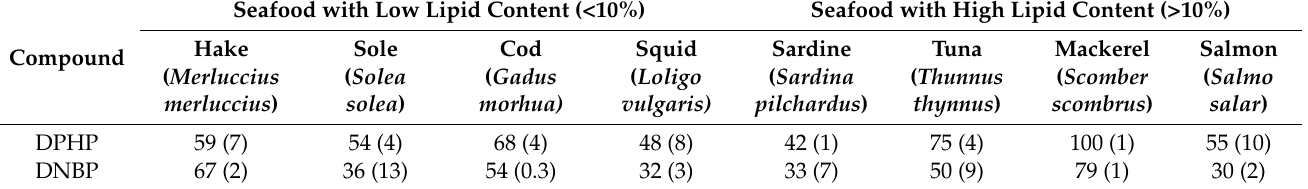
Table 3. Concentrations (ng g − 1 (d.w.)) and relative standard deviation (RSD%, n = 3) of organophos- phate diesters found in seafood species with different lipid